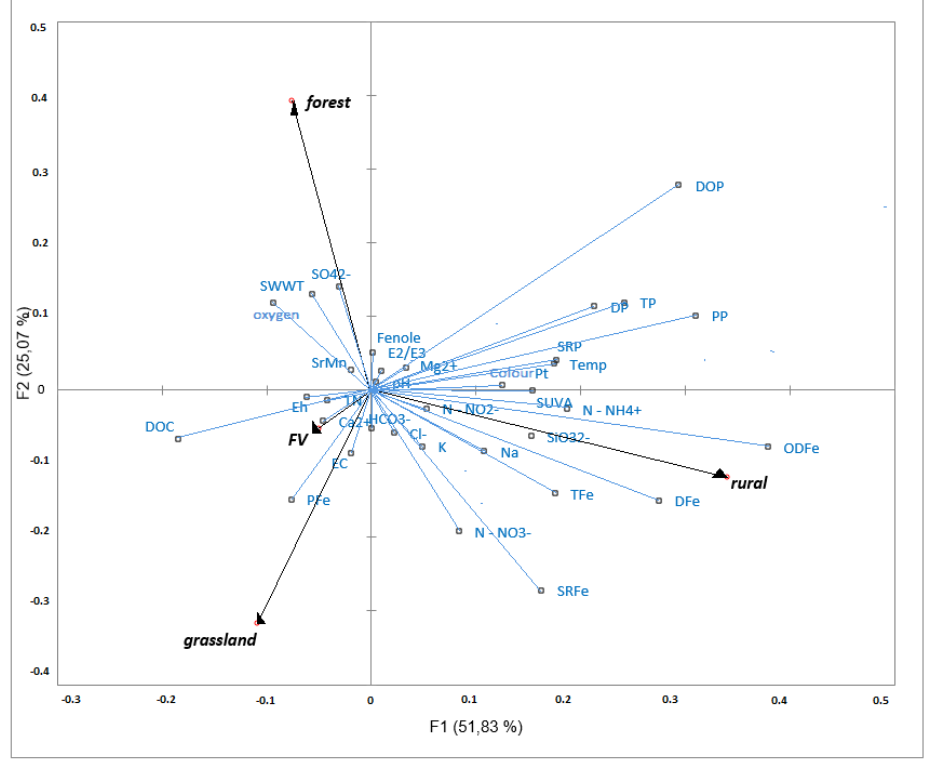
Figure 11. Redundancy analysis (RDA) of water quality parameters and influence factors.